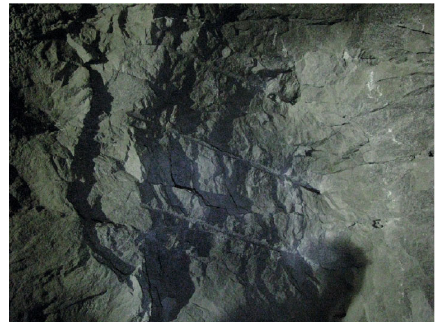
Figure 7: Actual tunnel contour after blasting.